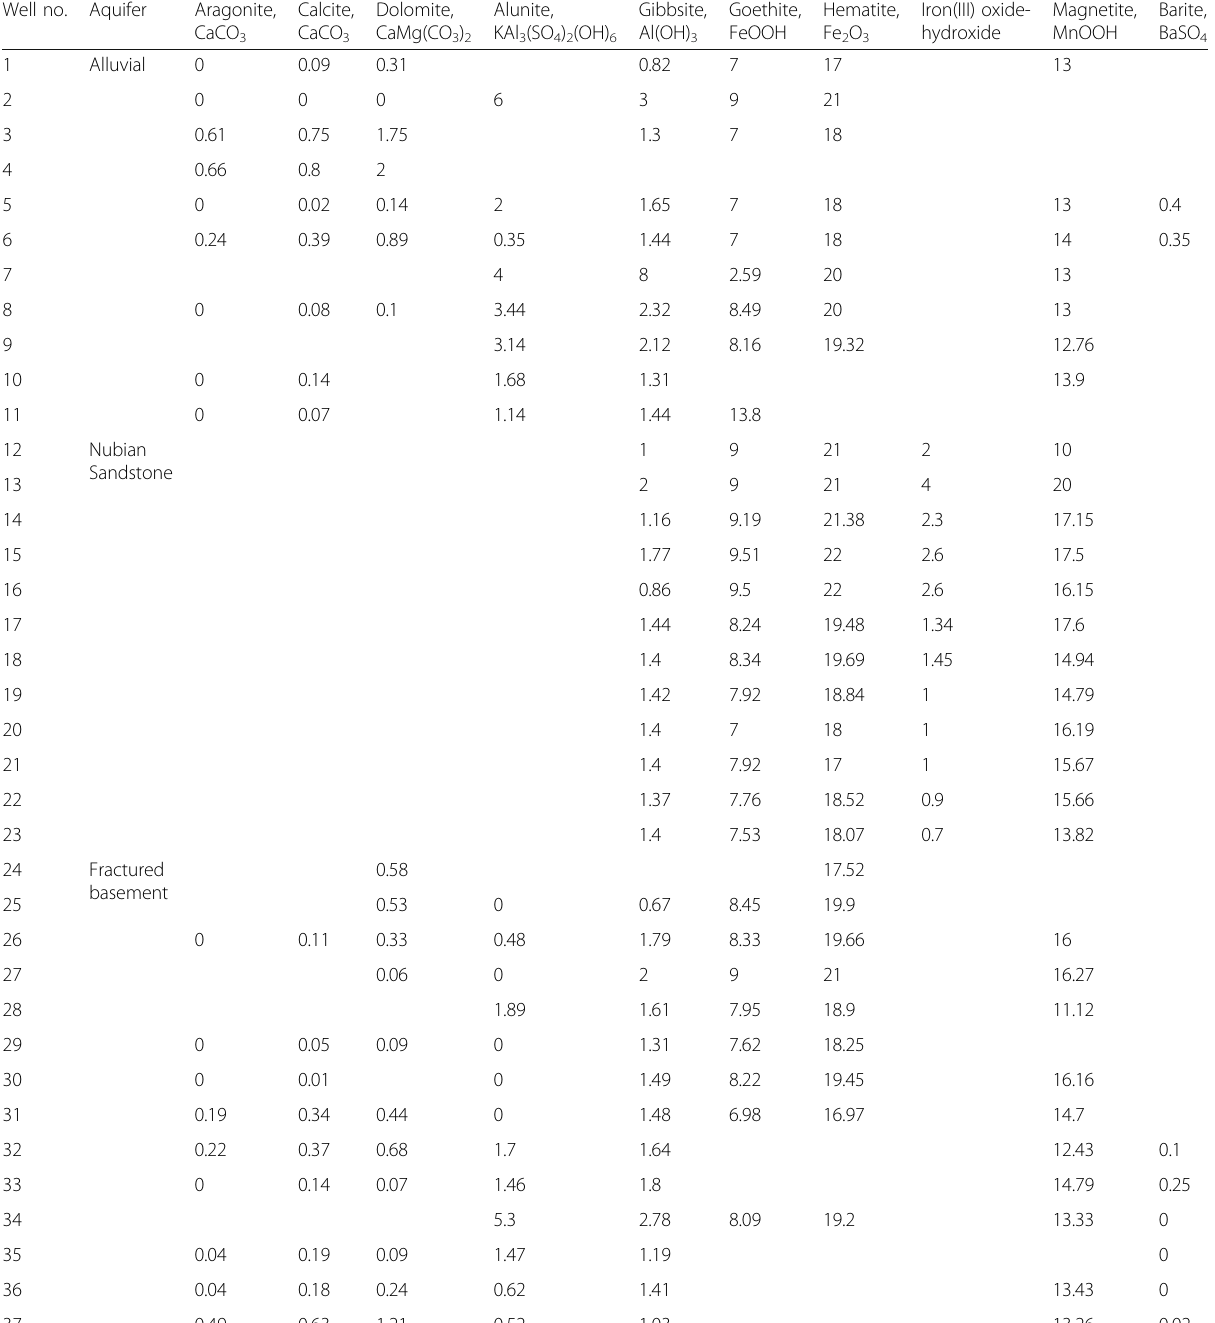
Table 6 Saturation indices of the studied groundwater samples, using PHREEQC geochemical model Well no.